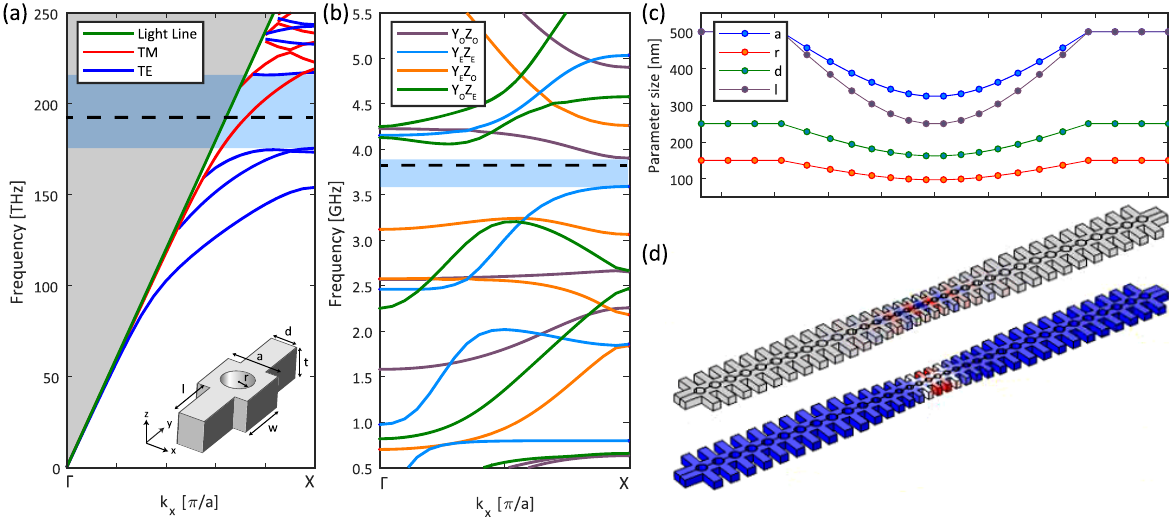
Figure 1: Design of a one-dimensional (1D) optomechanical (OM) crystal cavity with a full phononic bandgap. (a)Photonicbandsfortransverseelectric(TE-like)modesandtransversemagnetic(TM-like)modesforthemirrorunitcell.The gray-andlight- blue-shadedareasdenotethenon-guidedmodesandtheTE-likequasi-bandgap,respectively.(b)Phononicbandsformechanicalmodeswith different symmetries for the mirror unit cell. (c) Parameter variation to build the OM cavity for the nominal structure. (d) Optical resonance at λ (cid:1) 1530 nm and mechanical resonance at Ω / 2 π (cid:1) 3 . 82 GHz (dashed black line in (b)). The calculated OM coupling rate is g r m Thenominalparametersarewaveguidewidth w =570nm,andthickness t =220nm,stubmirror(defect)width l =500nm(250nm),stubmirror (defect)length d =250nm(163nm),holemirror(defect)radius r =150nm(98nm)andmirror(defect)period a =500nm(325nm).Simulations in (a) and (b) were performed with